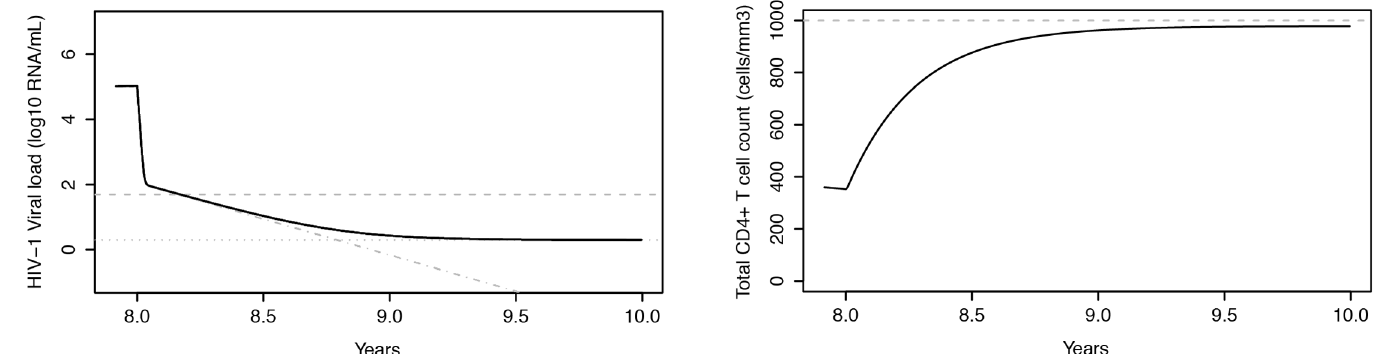
Fig 4. Evolution of plasma HIV-1 RNA levels and CD4+ T cell counts in a treated subject. Left: plasma HIV-1 RNA levels as a function of time, simulated by the HIV-D model with drug effect, when persistent (black line) and non-persistent (grey dashed-dotted line) low level viremia are considered. The horizontal grey dashed line corresponds to the common viral load detection threshold of 50 plasma HIV-1 RNA copies/mL, whereas the horizontal grey dotted line corresponds to a theoretically imputed persistent low level viremia of 2 plasma HIV-1 RNA copies/mL (considered for this particular example). Right: corresponding CD4+ T cell counts. Simulated treatment with hypothetical continuous drug potency ε = 100% starting at 8 years after seroconversion.